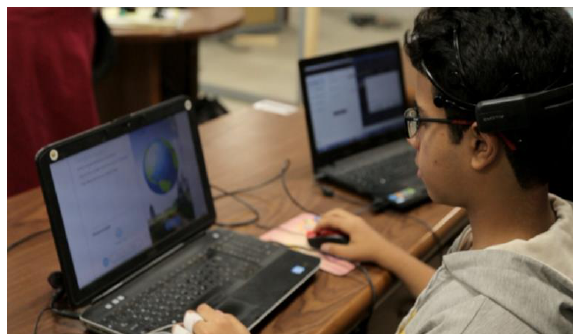
Figure 2. Experimental set-up. A subject undergoes the cognitive assessment test while wearing the EEG headset.